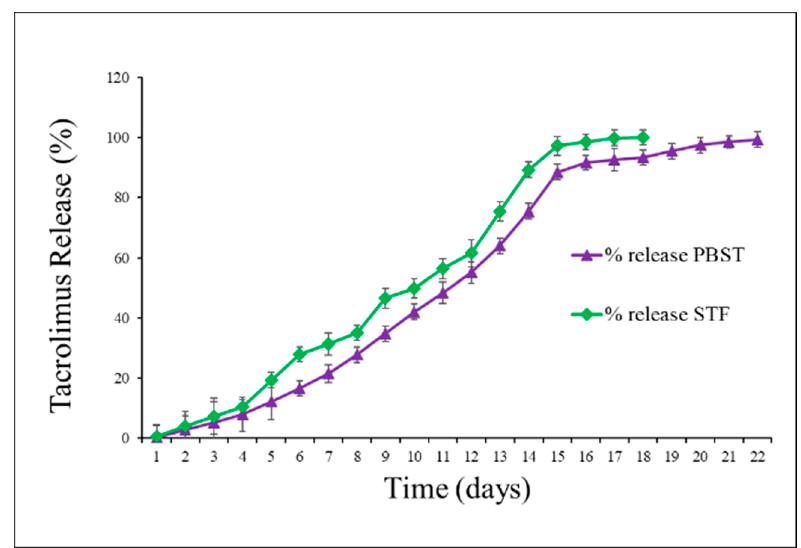
Figure 7. In-vitro release of Tacrolimus (TAC) from Tacrolimus nanomicellar formulation (TAC-NMF) evaluated in PBST and STF buffer solutions.